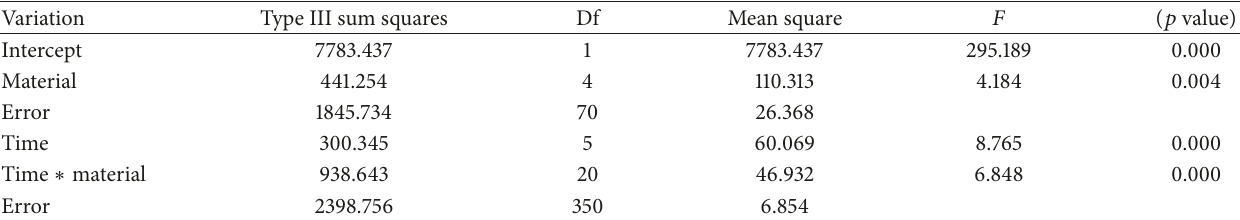
Table 2: Color variation results ( Δ𝐸 ∗ 00 ) by ANOVA with repeated measures with regard to the effects of weather and their interaction groups.